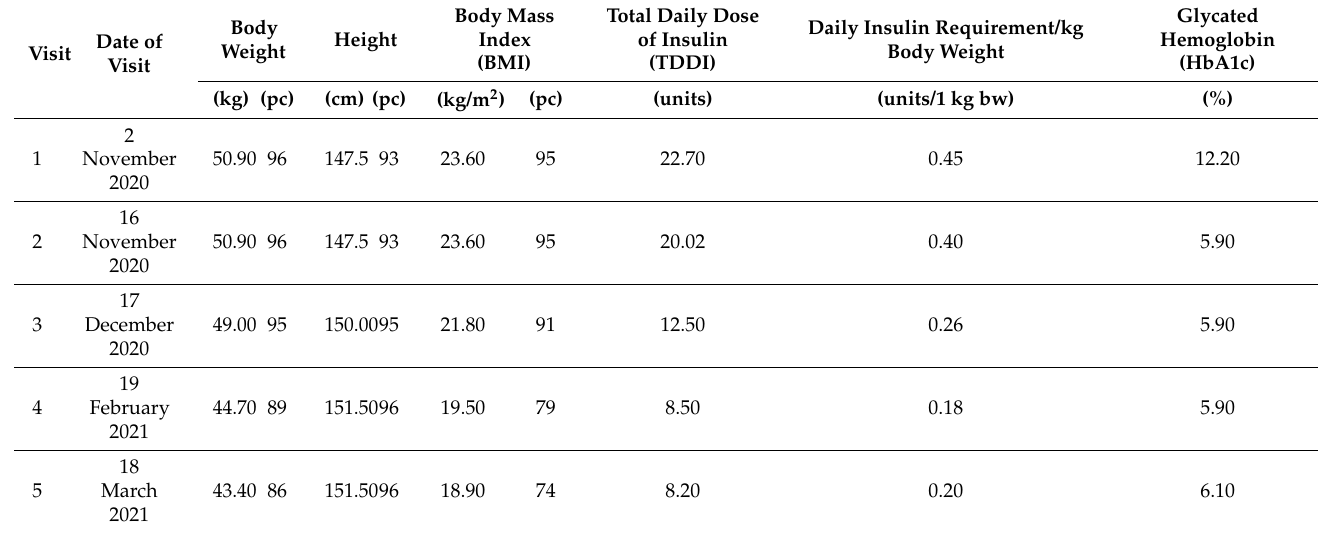
Table 1. Patient’s clinical data before and after connection to the MiniMed780G